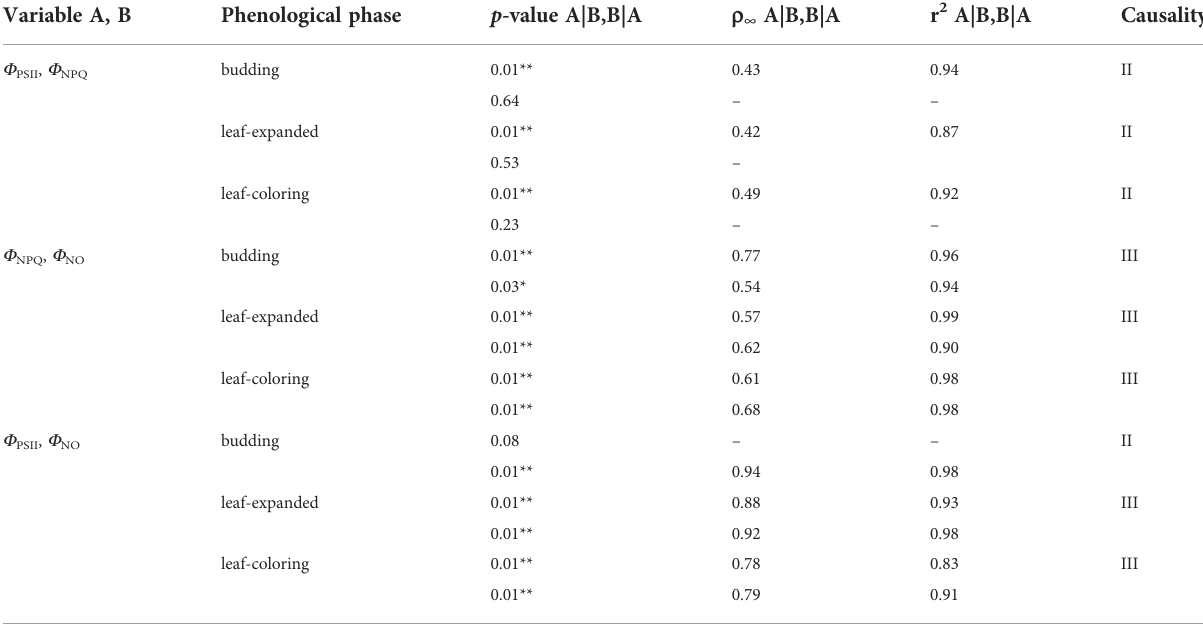
TABLE 3 Convergent cross mapping (CCM) with hourly data pairs relating three PSII-energy partitioning pathways for different phenological phases from 2012 – 2017 ( L n ~ 960 records); the number of bootstrapping iterations (n) = 1,000; and A|B and B|A stand for A forcing B and B forcing A, respectively.